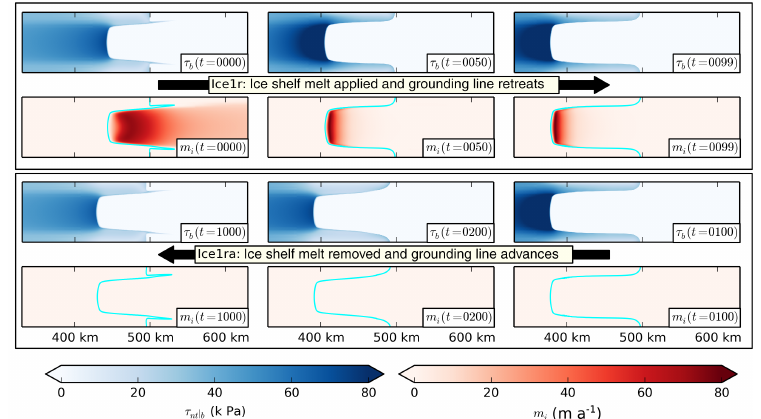
Figure 2. Evolution of the basal traction τ nt | z and ice shelf melt rate m i fields during the Ice1r and Ice1ra experiments from a BISICLES b run. Melt rates are applied when 0 < t < 100a, causing the ice shelf to thin and grounding line to retreat. Once t > 100a, no melt is applied, the ice shelf thickens, and the grounding line advances. The choice of the Tsai et al. (2015) traction law ensures that τ nt | z across the grounding line but large ∼ 1km upstream. Similarly, the factor tanh (H c /H c0 ) ensures that m i is continuous across the grounding line but large ∼ 10km